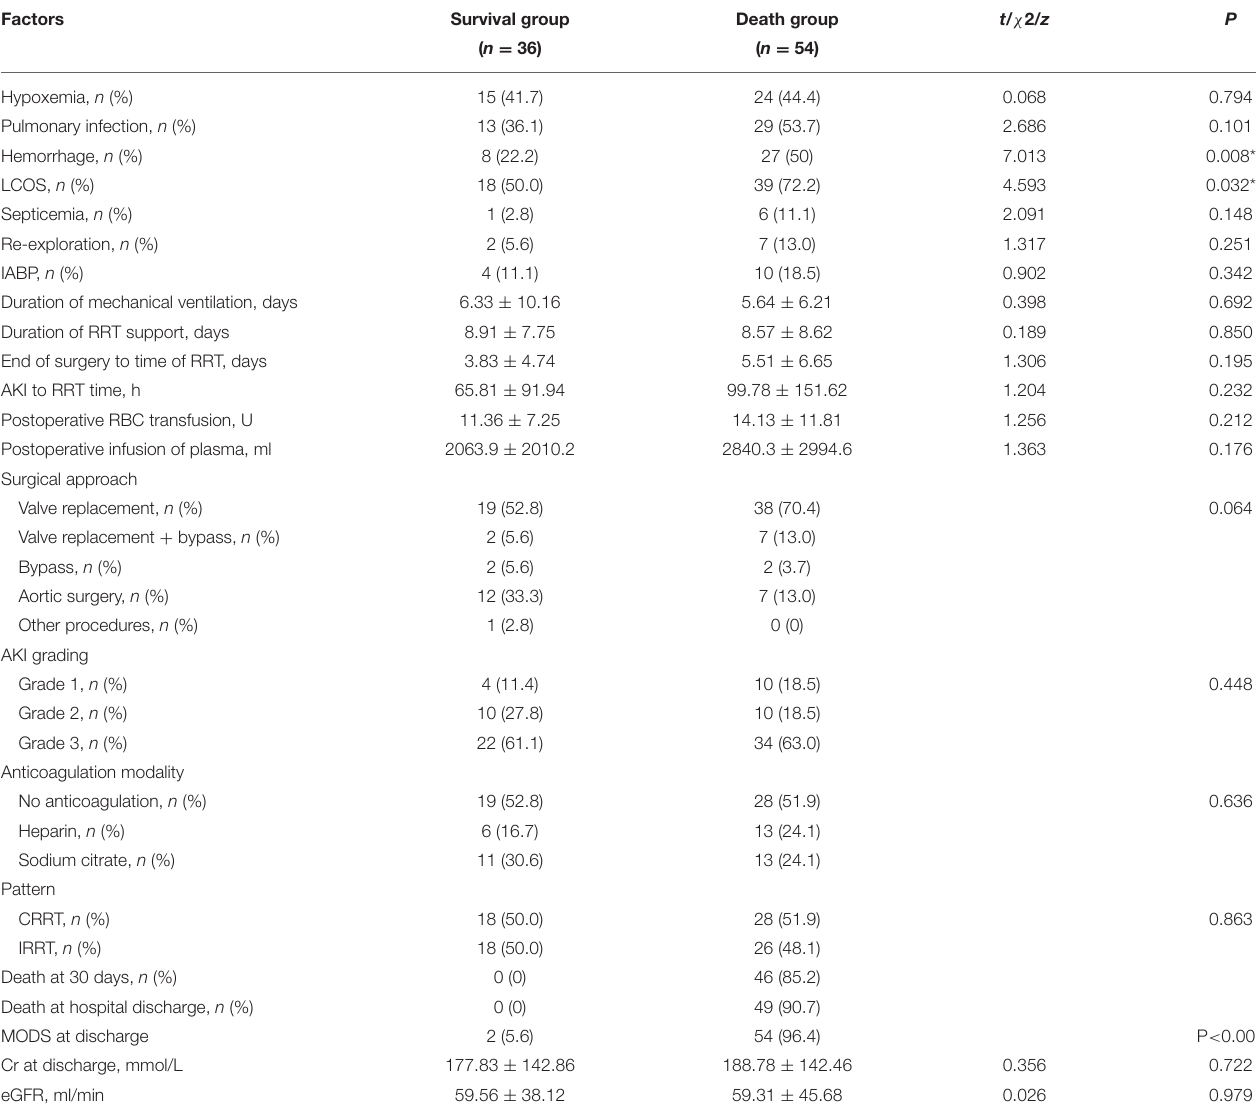
TABLE 3 | Postoperative relevant clinical indicators with dialysis-dependent acute kidney injury after cardiac surgery. Factors Survival group Death